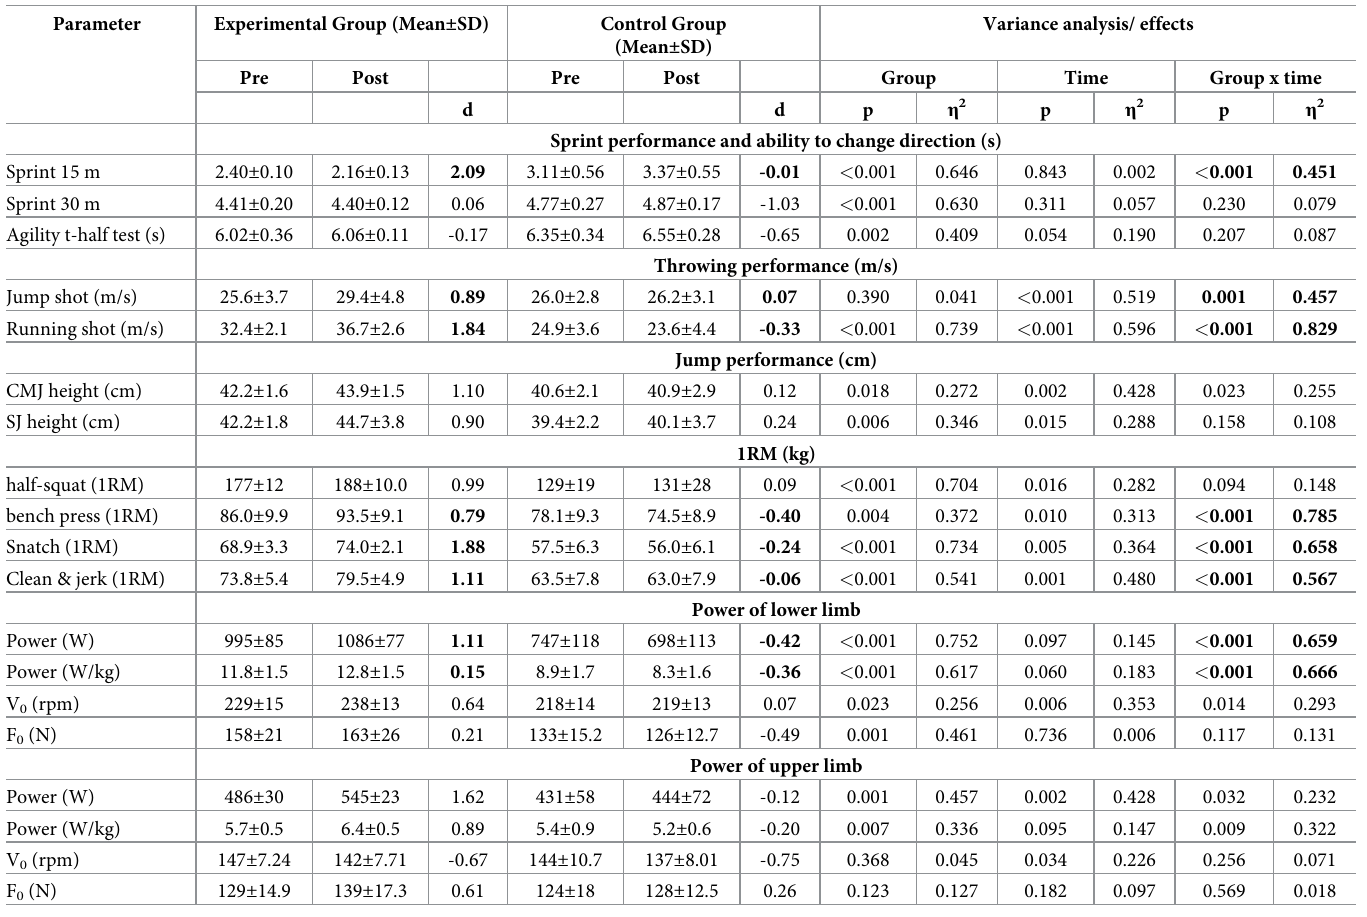
Table 3. Comparison between experimental and control groups before and after the 2-week tapering period (examination 2 vs. 3). Significant interaction effects and both effect sizes are highlighted in bold. Parameter